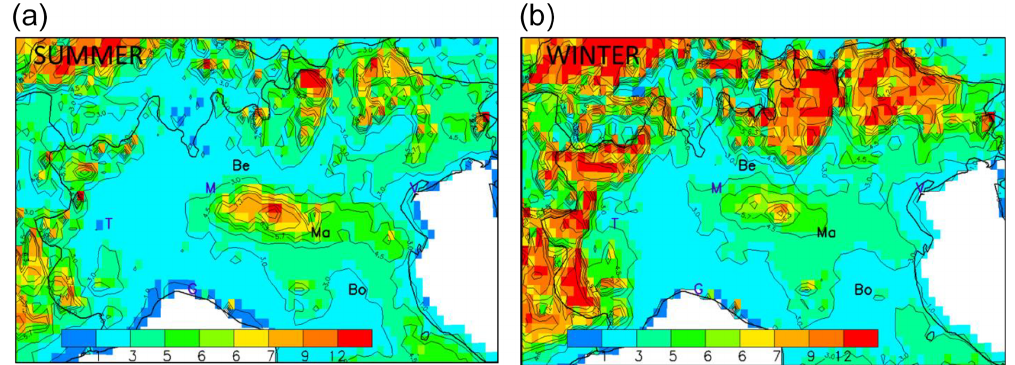
Figure 4. G ratio for winter (b) and summer (a) times. The abbreviations Be, Ma and Bo indicate the location of Bergamo, Mantua and Bologna, respectively. Other cities are indicated by their first letter for convenience: Venice, Milan, Turin and Genoa.